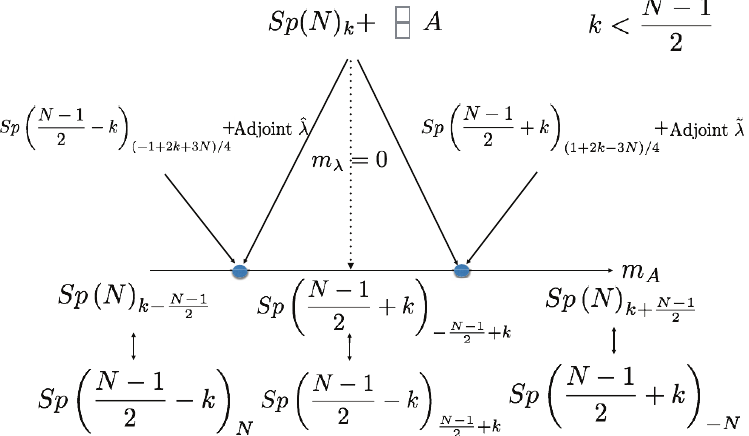
Figure 19: The phase diagram of Sp ( N ) antisymmetric-traceless tensor for k < N tween different infrared TQFTs. We propose a dual fermionic description of the two